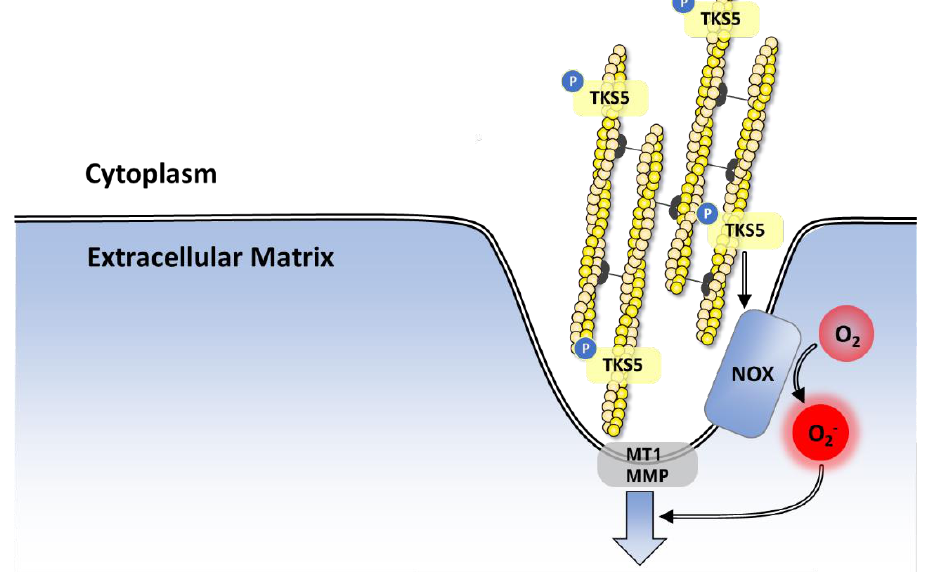
Figure 21. Invadopodia regulation model modulated by the association of Tks5 with NOX . Initial model proposed by [406] was further adapted to include the formation of Tks-5-NOX complex assembly and subsequent activation of ROS-mediated invapodia formation. Inspired by [406].